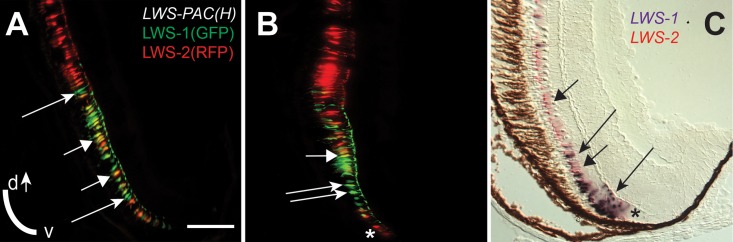
An “LWS Transition Zone” exists in ventral retina of juvenile fish.Sections of retina from one-month old juvenile retinas are shown. A and B. Two different sections from separate LWS:PAC(H) transgenic fish showing LWS1:GFP+ cones (green fluorescence; long arrows), LWS2:RFP+ cones (red fluorescence), and cones co-expressing LWS1:GFP and LWS2:RFP (yellow, short arrows). B. The asterisk (*) indicates a cone expressing only LWS2:RFP at the ventral periphery. C. Dual in situ hybridization using cDNA probes for LWS1 (purple) and LWS2 (red/pink). Cones expressing LWS1 only are indicated by long arrows; cones co-labeled with both probes are indicted by short arrows. The asterisk (*) indicates an LWS2 singly labelled cone at the ventral periphery. Scale bar in A (applies to all) = 25 μm; v, ventral; d, dorsal.